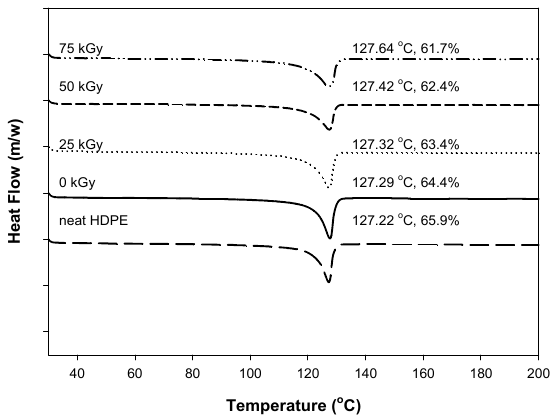
Figure 6. Differential scanning calorimetry (DSC) micrographs of PU (3 phr)/HDPE composites at various absorption doses.